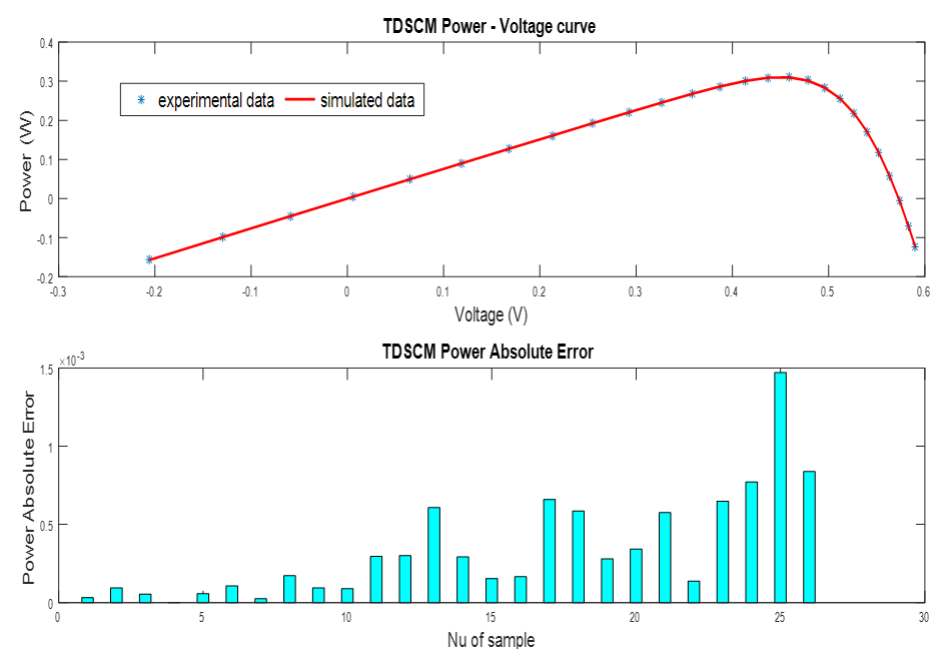
Figure 9. The P-V curve and power absolute error for